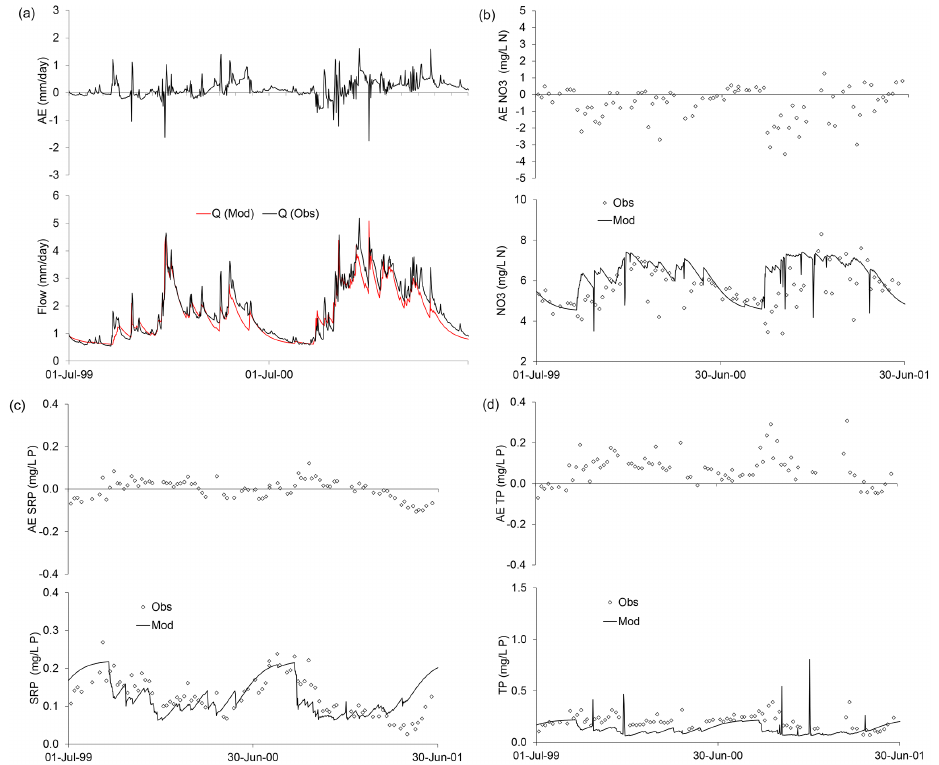
Figure 5. Time series plots of modelled (from “expert” calibration) and observed (LTD) flows and nutrient data, with the absolute error (AE) (observed minus modelled) shown above: (a) flows, (b) nitrate, (c) TP and (d) SRP. Two years of data shown only. Table 6. Sensitivity analysis results